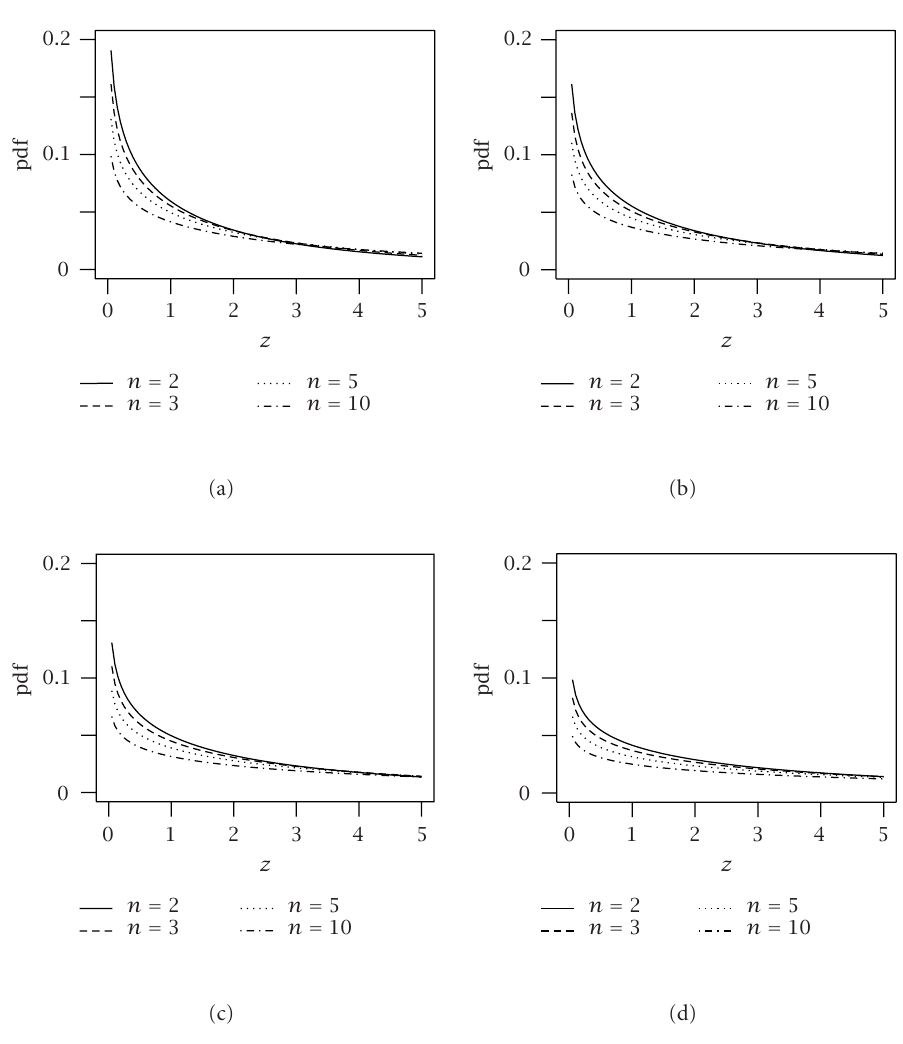
Figure 2.1. Plots of the pdf (2.1) for b = 1, β = 1, and (a) m = 2; (b) m = 3; (c) m = 5; and (d) m = 10.